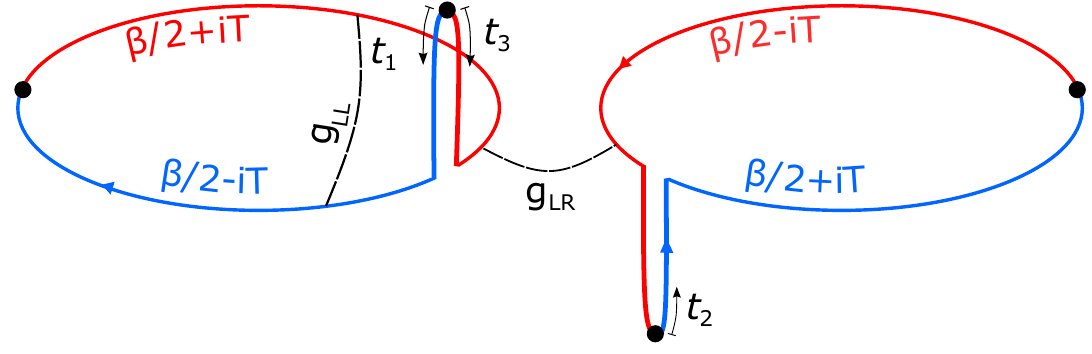
Figure 12 . Contour relevant for the Renyi-2 wormhole, with our conventions labeled. The black arrows start at the points where t i = 0 and they point in the direction of positive t i . The correlator between points t 1 and t 2 behaves as if they are on two sides of a thermofield